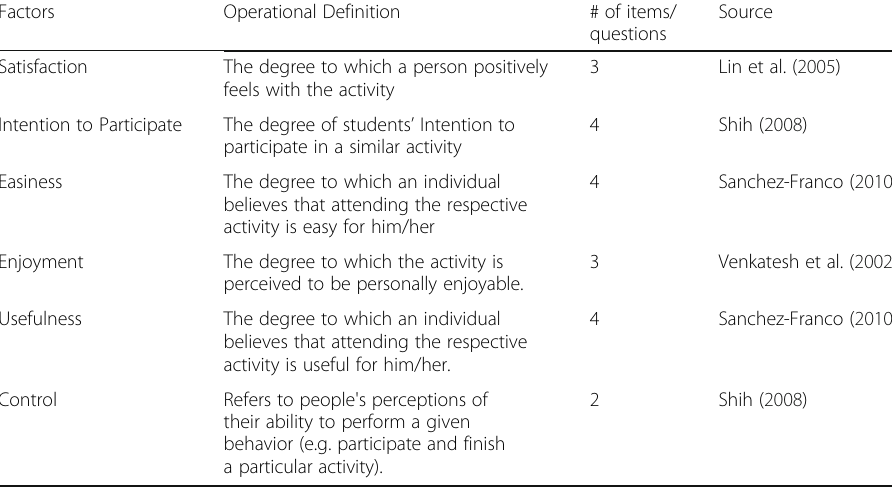
Table 3 The factors used in the survey